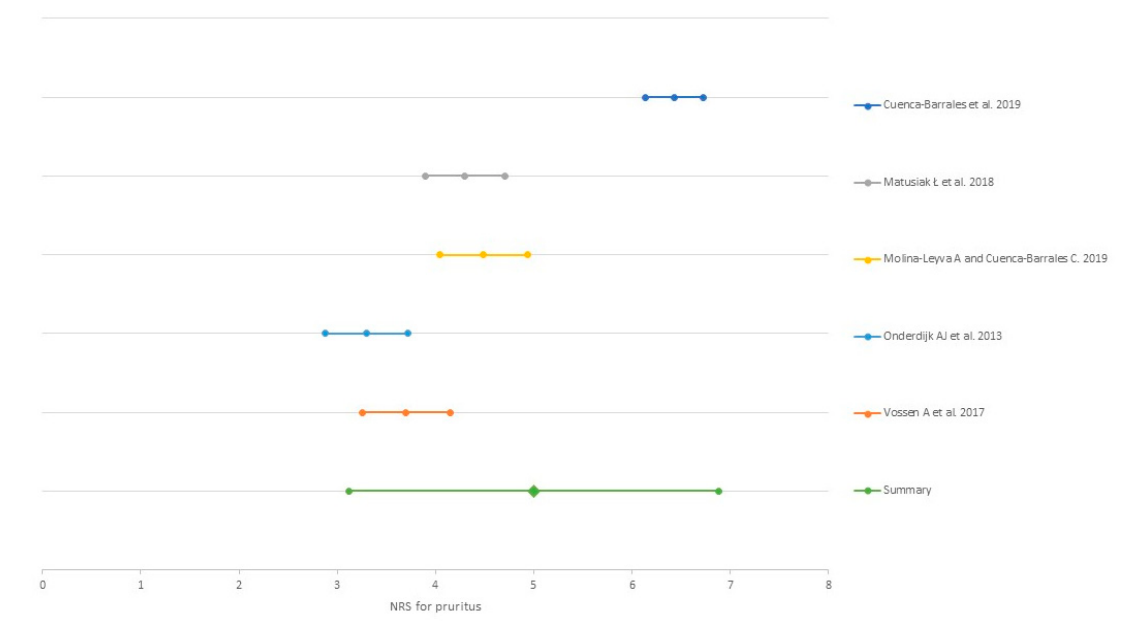
Figure 4. Meta-analysis of the mean Numerical Rating Scale for pruritus reported in the studies. Factors associated with increased risk of pruritus were higher BMI, longer disease